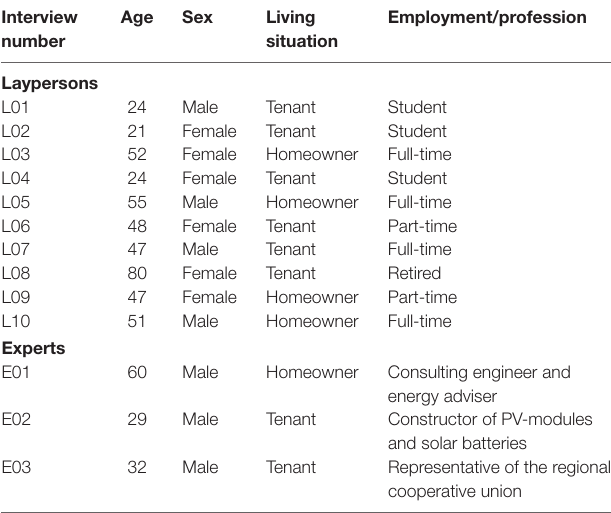
TaBle 2 | Characteristics of interviewed laypersons and